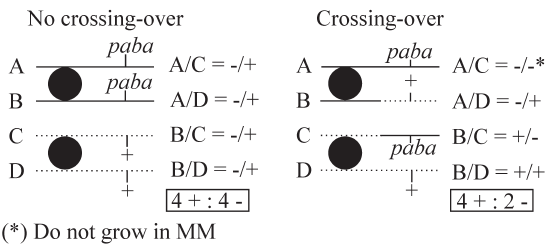
Figure 1 - Origin of heterozygous (+//- and -//+) and homozygous (+//+) diploids promoted by mitotic crossing-over between paba and the